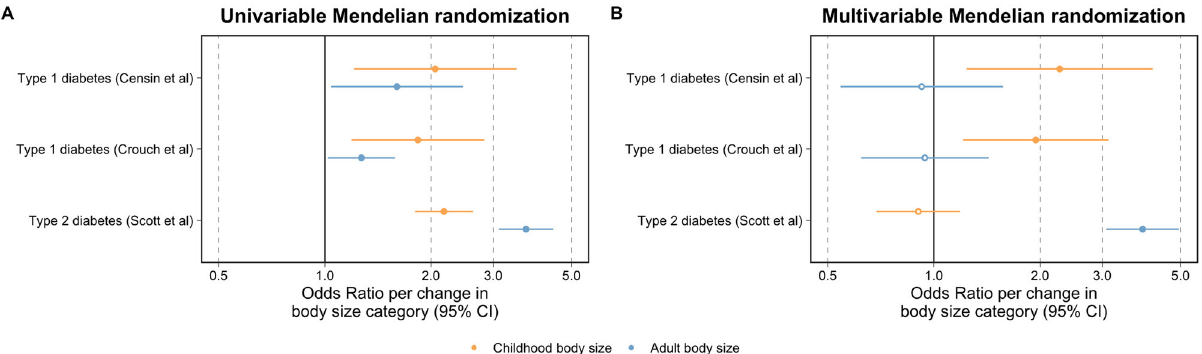
Fig. 2 Forest plots illustrating the total and direct effects of childhood body size on type 1 and type 2 diabetes risk. A The univariable Mendelian randomisation (MR) estimates between childhood (yellow) and adult (blue) body size ( n = 453,169) on risk of type 1 (using estimates from both discovery ( n = 14,741) and replication analysis ( n = 173,981)) and type 2 diabetes ( n = 159,208) and B their corresponding multivariable MR estimates. Odds ratios are per change in body size category. 95% CI 95% con fi dence interval. Central estimates are illustrated as circles which were fi lled when con fi dence intervals did not overlap with the null. The data underlying these fi gures can be found in Supplementary Data 9, 13